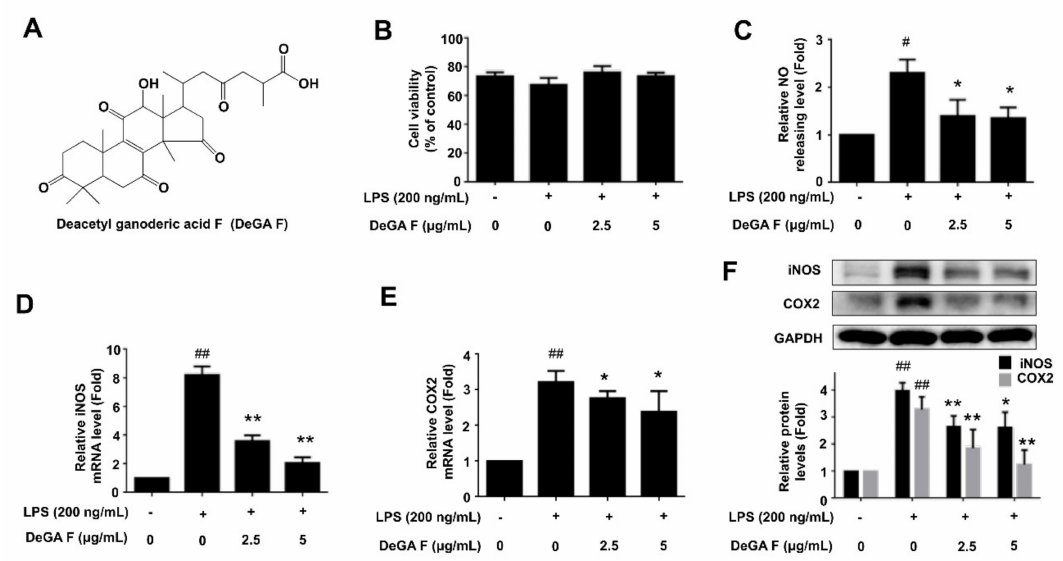
Figure 1. Deacetyl ganoderic acid F (DeGA F) inhibited Nitric oxide (NO) production and iNOS expression in LPS-stimulated BV-2 cells. ( A ) Chemical structure of DeGA F. ( B ) Cells were pretreated with DeGA F for 1 h, and then exposed to LPS for another 24 h. Cell viability was detected using CCK-8 assay. ( C ) NO releasing levels in the cell culture medium were detected by Griess assay. ( D , E ) The mRNA levels of iNOS and COX-2 were measured by qPCR analysis. ( F ) Protein levels of iNOS and COX-2 were detected by Western blot analysis. LPS, lipopolysaccharide. – and + represented the absence or presence of LPS (200 ng / mL), respectively. # p < 0.05 and ## p < 0.01 compared with blank group ( n = 3). * p < 0.05 and ** p < 0.01 compared with the LPS group ( n =